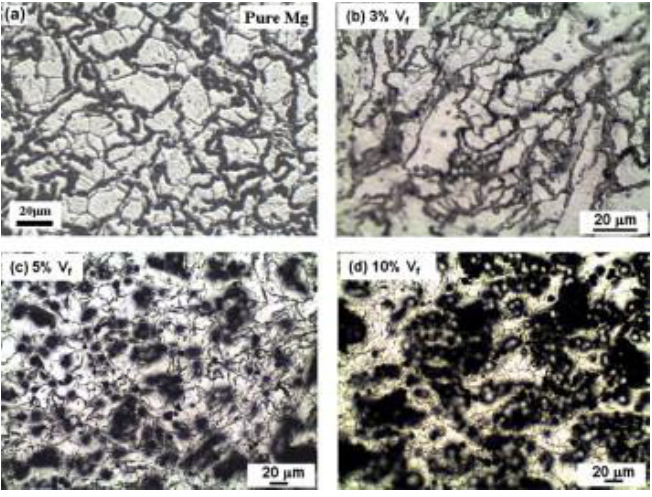
Figure 12. ( a ) Grain characteristics of pure Mg, and ( b – d ) its composite reinforced with different amounts of Ni 60 Nb 40 amorphous reinforcement (reprinted from Jayalakshmi et al . 2014 [16], with permission from © Elsevier).